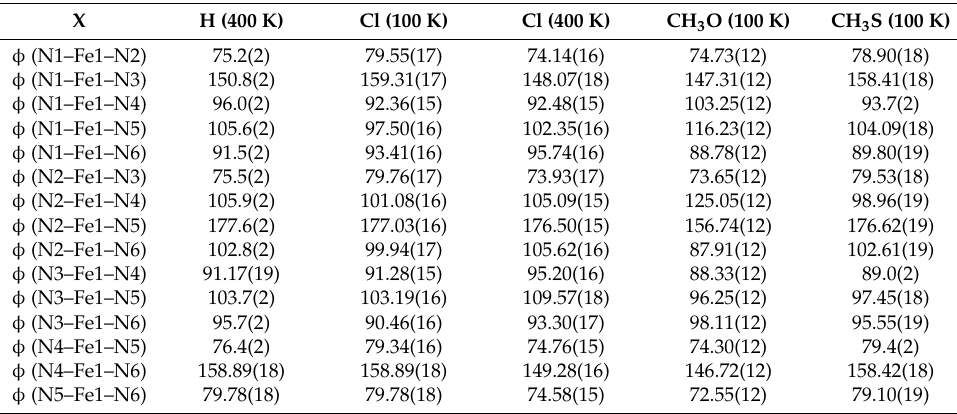
Table 3. N–Fe–N bond angles ( φ ) in ◦ for [Fe(X-pybox) 2 ](ClO 4 ) 2 (X = H, Cl, CH 3 O, CH 3